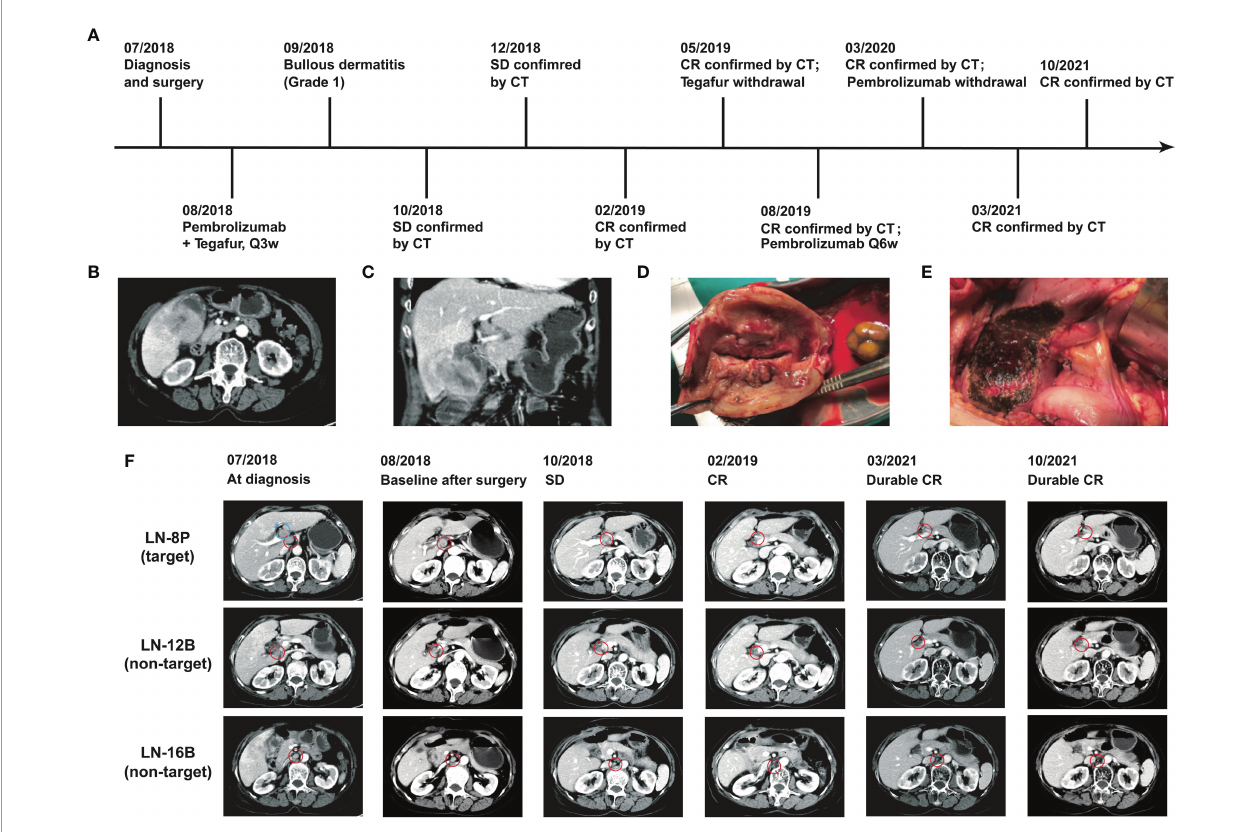
FIGURE 1 | Clinical courses and outcomes of this GBC patient. (A) Chronological schema of treatments. (B) Transverse images of CT scan. (C) Coronal images of CT scan. (D) Resection of gallbladder and (E) resection on partial liver. (F) CT images of the lesions during the treatments. Blue circle indicates the dissected lymph node